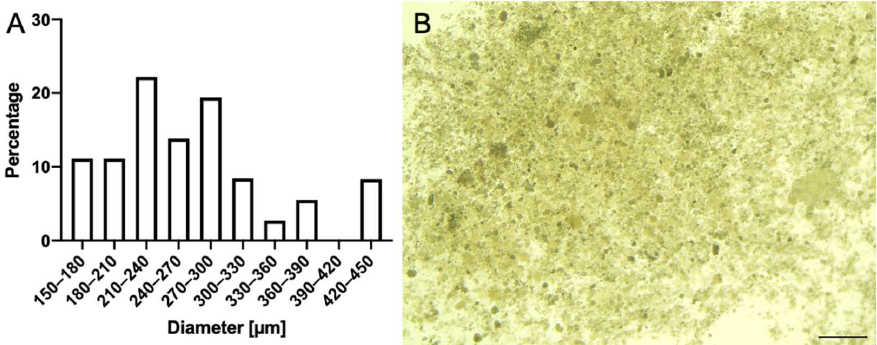
Figure 8. Observation of clusters from the medium with Pseudomonas aeruginosa containing 5 mM nickel oxide NPs using light microscopy and statistical analysis of the cluster size. The X -axis depicts the size of the cluster and the Y -axis shows the relative percentage ( A ). Cluster formation of nickel oxide ( B ). Note that the majority of the clusters were between 210 and 300 µm in size. Scalebar = 1 mm.